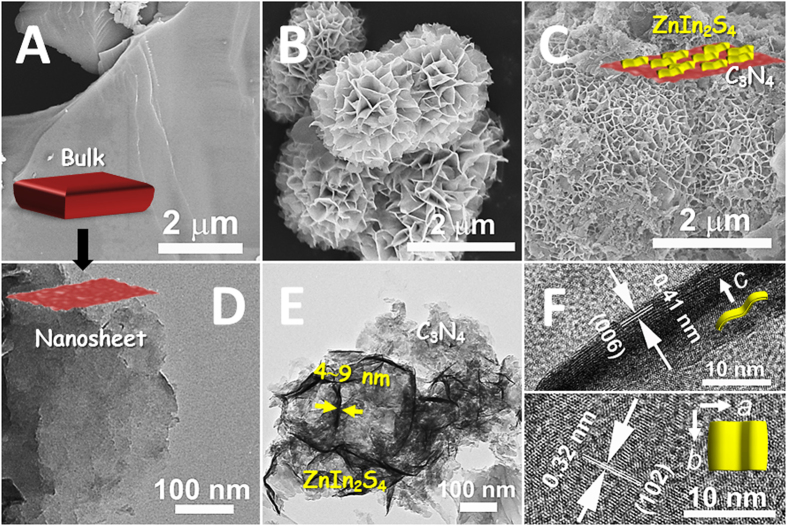
SEM images of (A) bulk g-C3N4, (B) ZnIn2S4 nanosheets, and (C) ZnIn2S4/g-C3N4 heterojunction nanosheets; TEM images of (D) the exfoliated g-C3N4 nanosheet and (E) 15 wt% ZnIn2S4/g-C3N4 heterojunction nanosheets; (F) HRTEM images of the side view and top view of ZnIn2S4 nanosheet grown on the g-C3N4 nanosheets. Insets showing structure schematic diagrams of the corresponding samples.